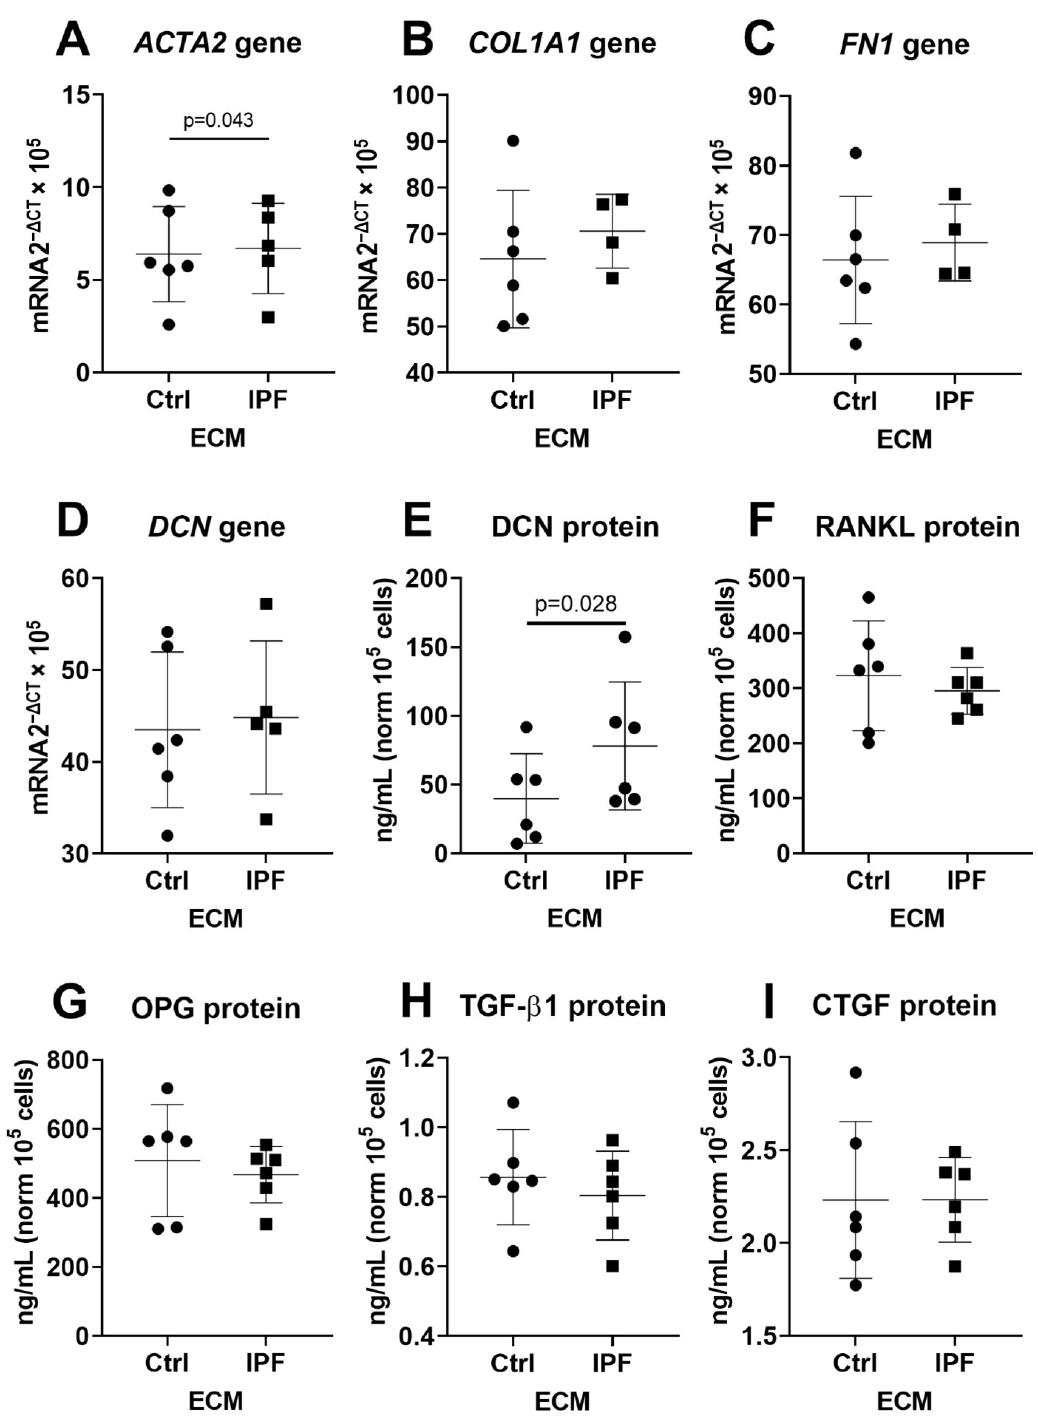
Figure 3. Effect of IPF-derived ECM on the expression of fibrosis-associated genes and secretion of profibrotic cytokines. Fibroblasts were cultured for three days on Ctrl- or IPF-derived ECM before expression levels of ACTA2, COL1A1, FN1 and DCN were assessed ( A – D ). The secretion of known fibrotic factors DCN, RANKL, OPG, TGF- β 1 and CTGF was also evaluated ( E – I ) ( n = 4–6). Wilcoxon matched pairs signed rank test was used to measure difference between Ctrl and IPF and was considered significant at p <